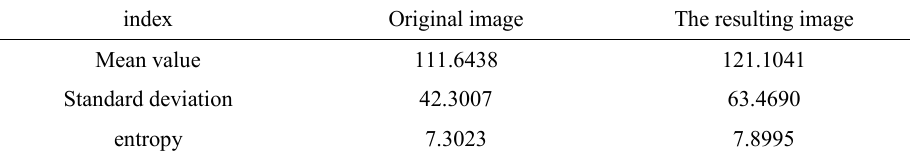
Table 2 Comparison of indicators of original image and processed